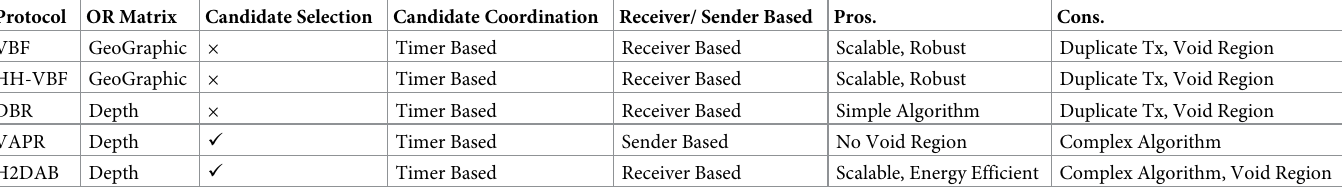
Table 1. Summary of the protocols. Candidate Selection Candidate Coordination Receiver/ Sender Based